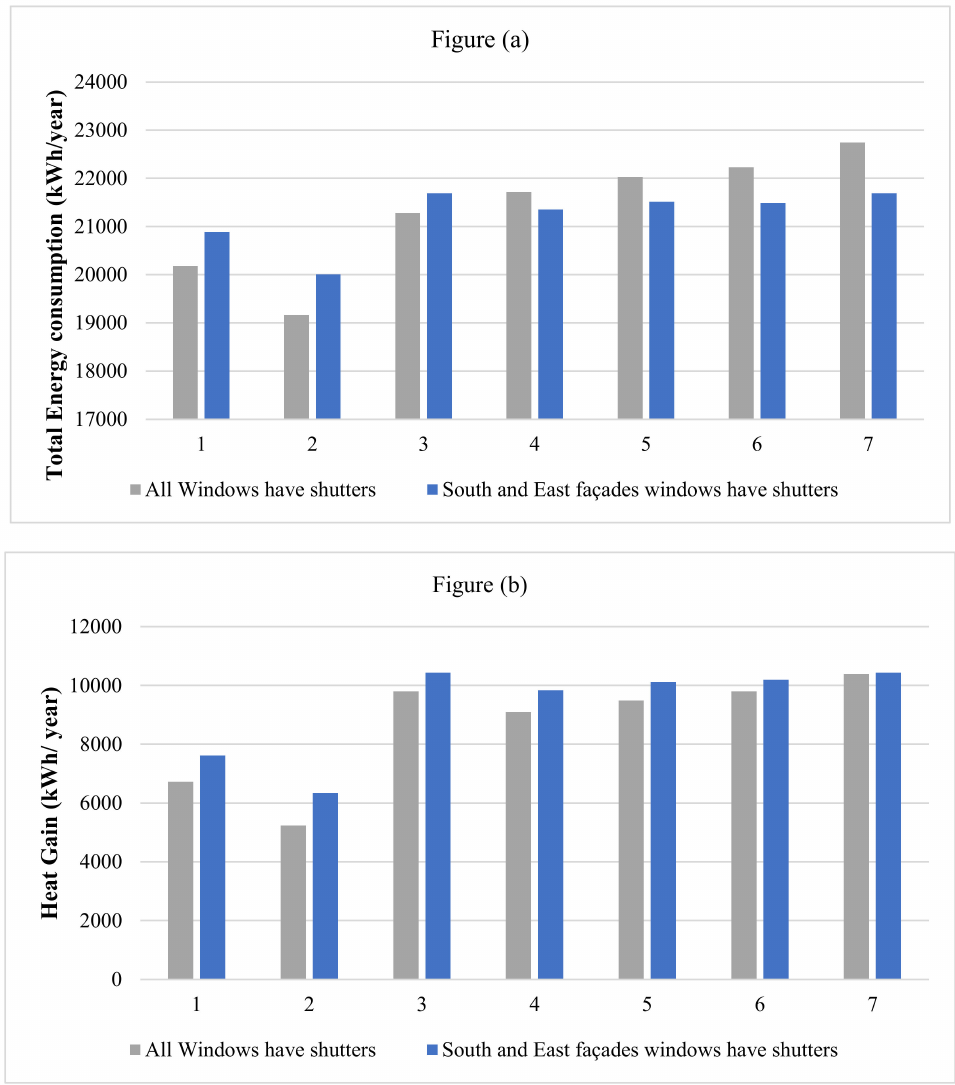
Figure 11. The total energy consumption ( a ) and heat addition ( b ) for the first case scenario: all windows have shutters and second case scenario: south and east windows have shutters with seven different windows shutter